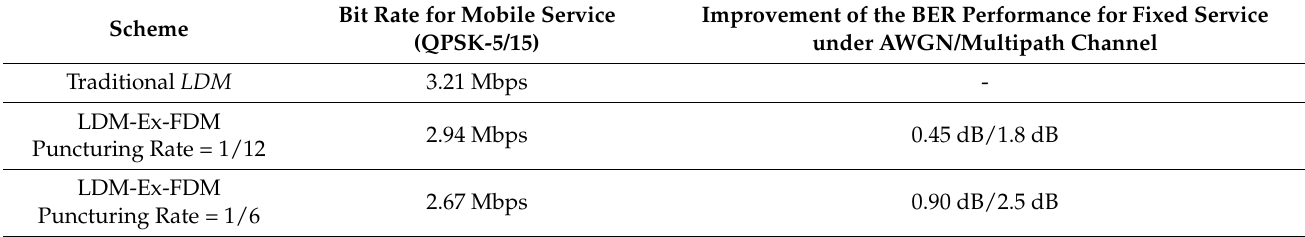
Table 3. Bit rate for mobile service and the improvement of the BER performance for fixed service under the AWGN and multipath channels.